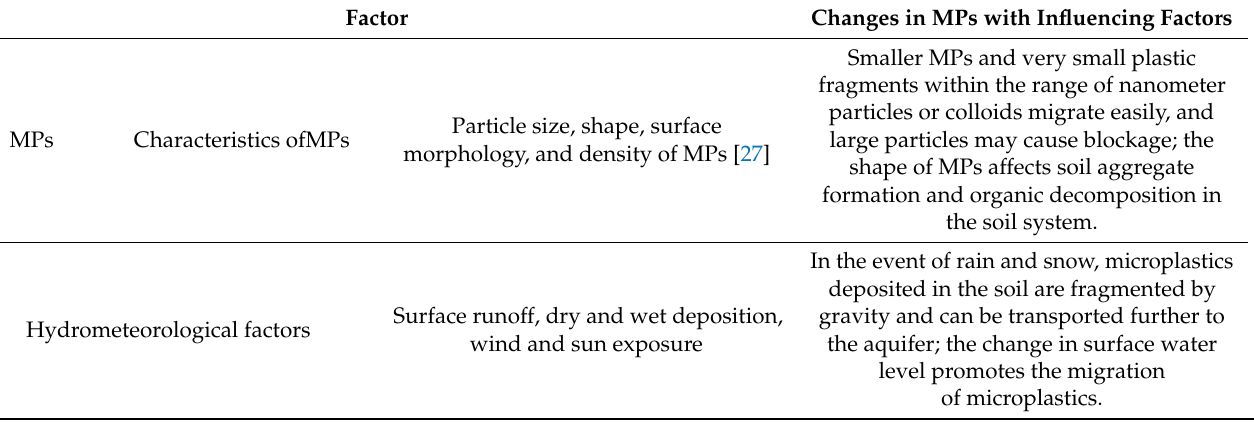
Table 1. Influence factors of MPs migration in unsaturated porous